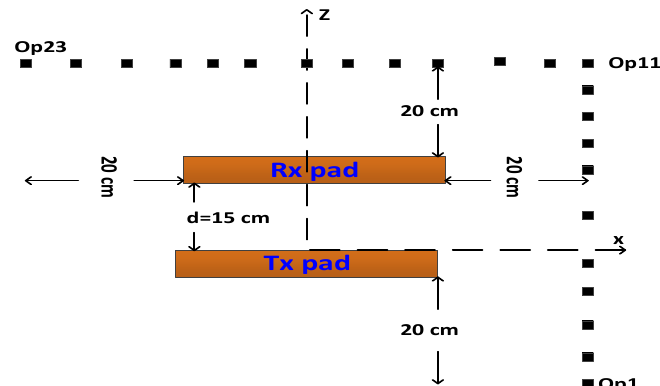
Figure 17. Observation points configurations for testing the Electromagnetic Field (EMF) level on the x and z